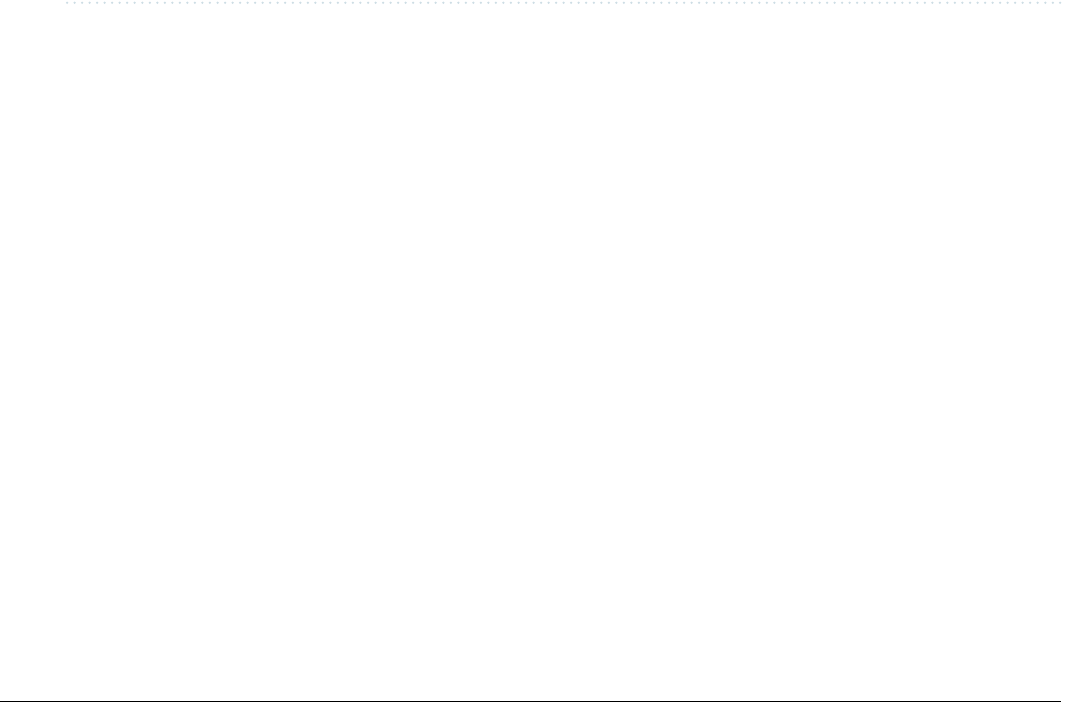
Figure 9. Distribution of the Nusselt number along ( a ) simple, ( b ) sinusoidal, ( c ) triangular, ( d ) square tube in presence of different magnetic